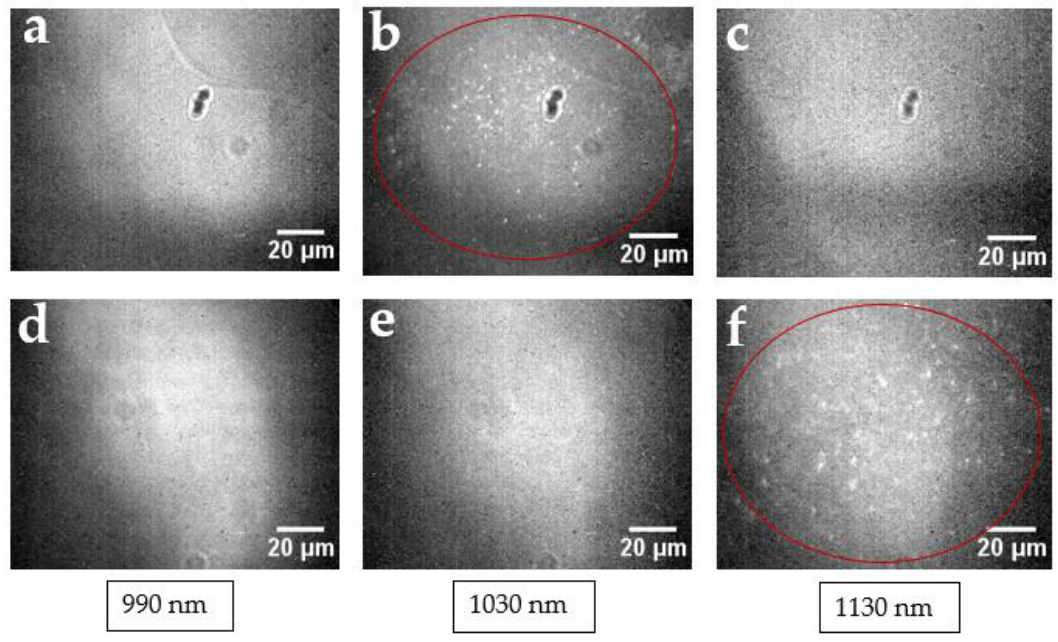
Figure 2. Near-infrared (NIR) hyperspectral images of (7,5) sorted SWCNTs at ( a ) 990, ( b ) 1030, and ( c ) 1130 nm; and (7,6) sorted SWCNTs at ( d ) 990, ( e ) 1030, and ( f ) 1130 nm. SWCNT fluorescence is only observed at the emission wavelengths of the corresponding sorted SWCNTs.